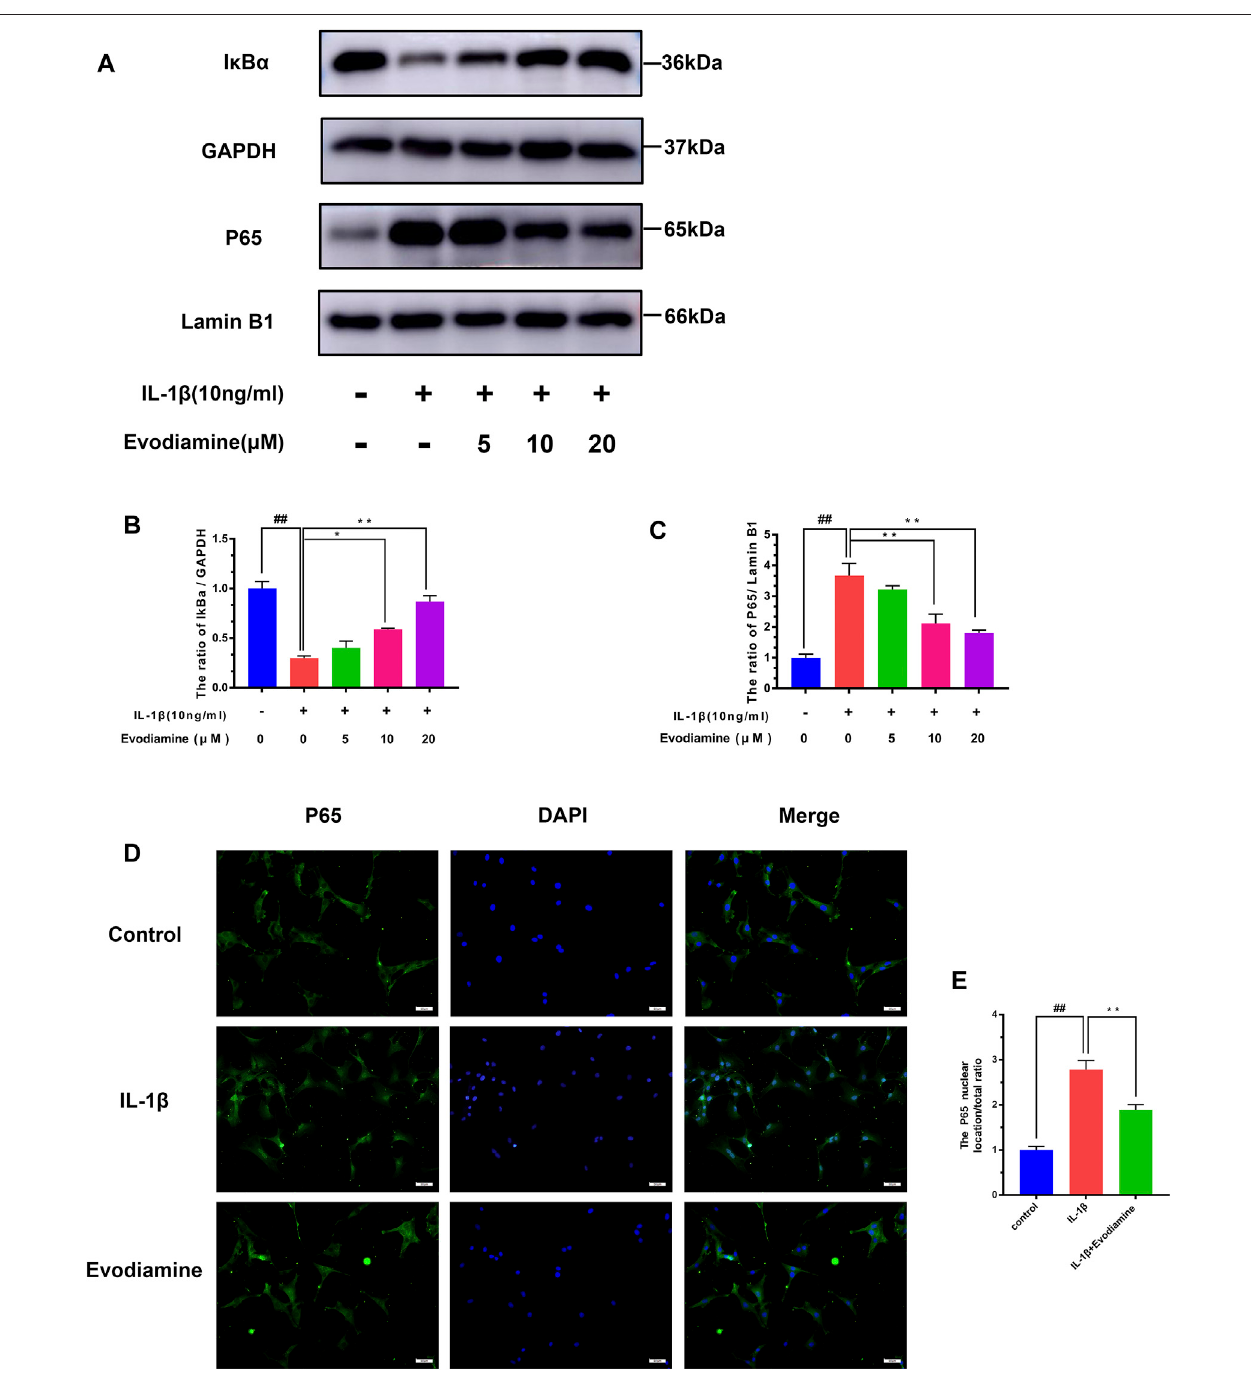
FIGURE 5 | Evodiamine exerts anti-in fl ammatory effects in OA by modulating the NF- κ B pathway. (A,B,C) Relative protein expression of I κ B- α and p65 was quantitated using Western blot. (D,E) p65 (red) was detected by immuno fl uorescence. Data were expressed as mean ± SD. Signi fi cant differences between different groups are indicated as ## p < 0.01, vs. control group; pp p < 0.01, vs. IL-1 β alone stimulation group, n = 3.